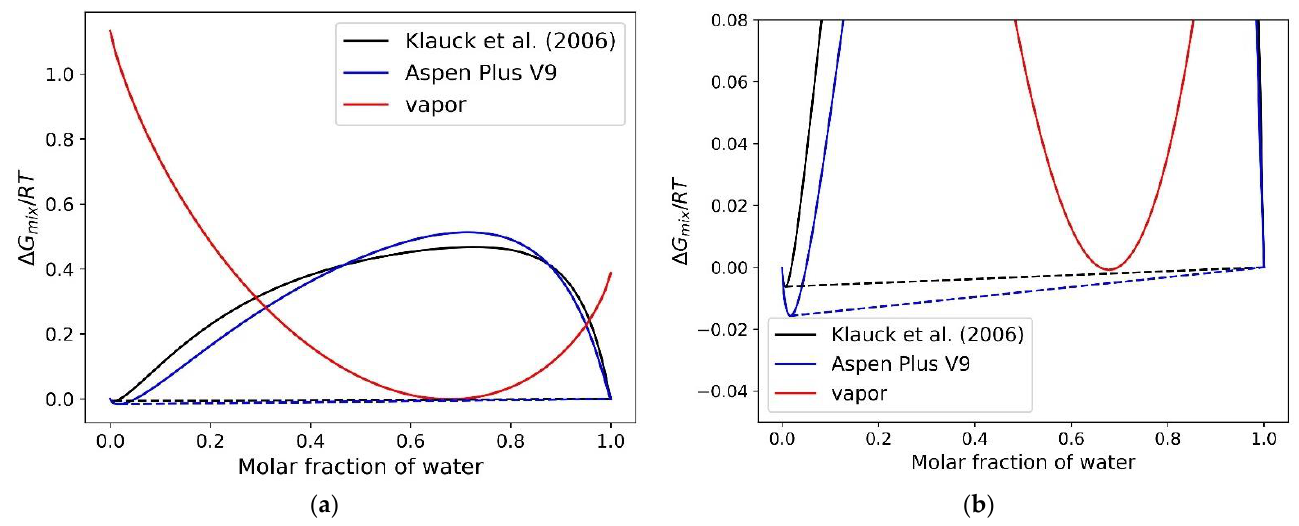
Figure 6. Vapor–Liquid–Liquid Equilibrium: ( a ) ∆ G mix /RT including the full range of values, ( b ) ∆ G mix /RT close-up for water/n-octane system at 1 atm and T = 89.5 °C.